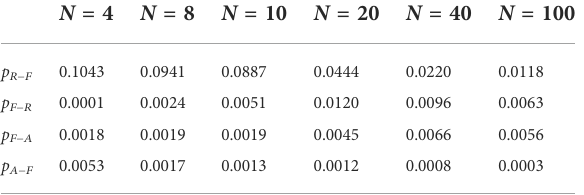
TABLE 1 Recorded μ M-C transition probabilities obtained through μ M-A